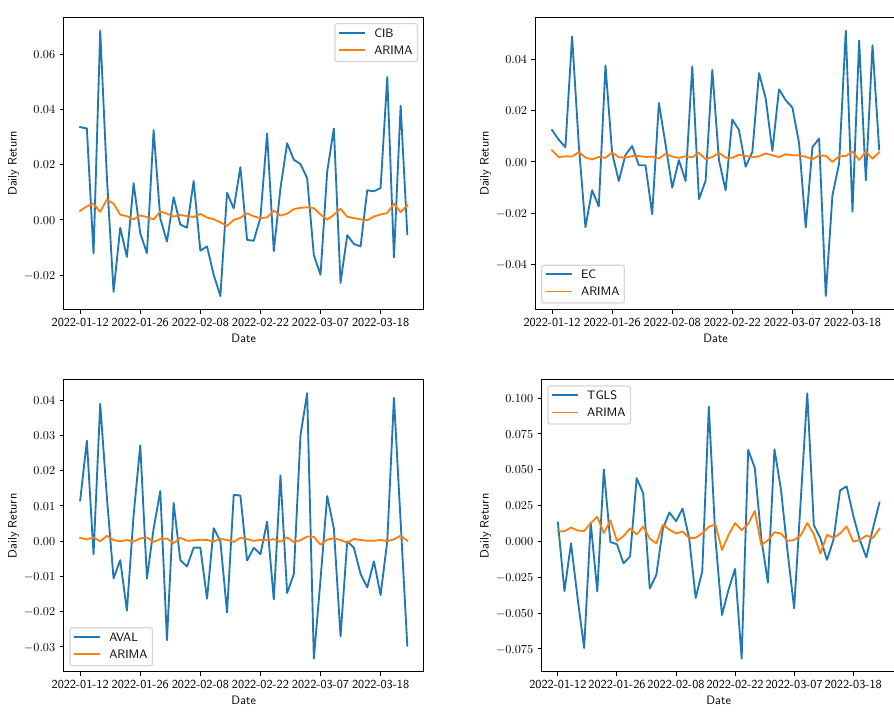
Figure 3. Real vs. ARIMA adjustment for daily returns of Bancolombia, Ecopetrol, Grupo AVAL, and Tecnoglass. The real time series is represented by the share symbol and its prediction with the model name in the legend.